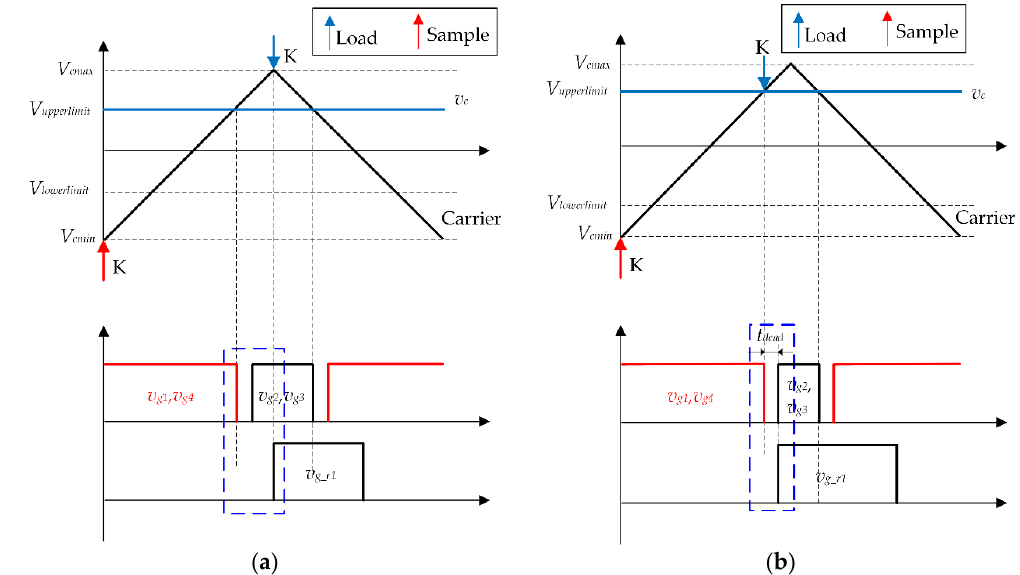
Figure 5. DPWM diagram at the condition of I o_ max and D max : ( a ) conventional loading scheme; ( b ) improved loading scheme.